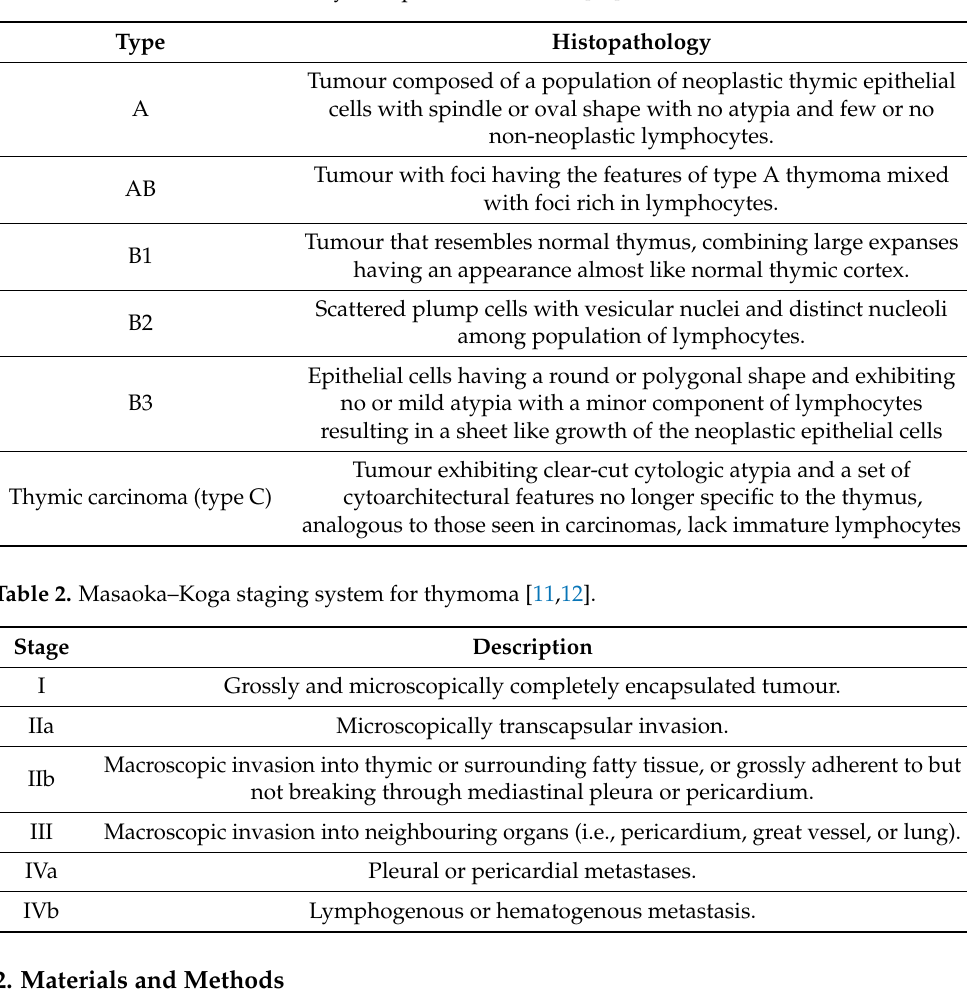
Table 1. WHO Classification of Thymic Epithelial Tumours [10].